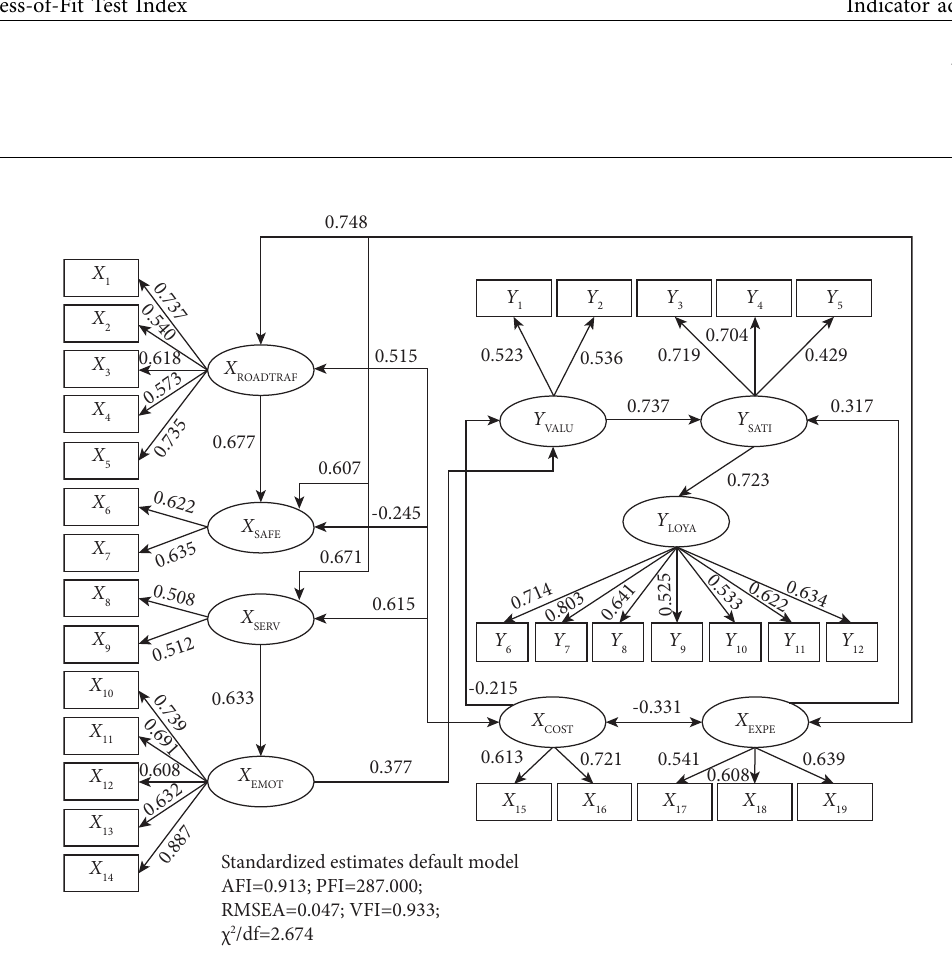
Figure 5: Results of the adjusted model.